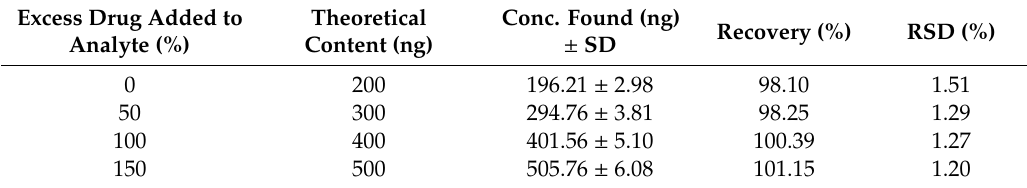
Table 3. Accuracy data of HPTLC method (mean ± SD; n = 6).